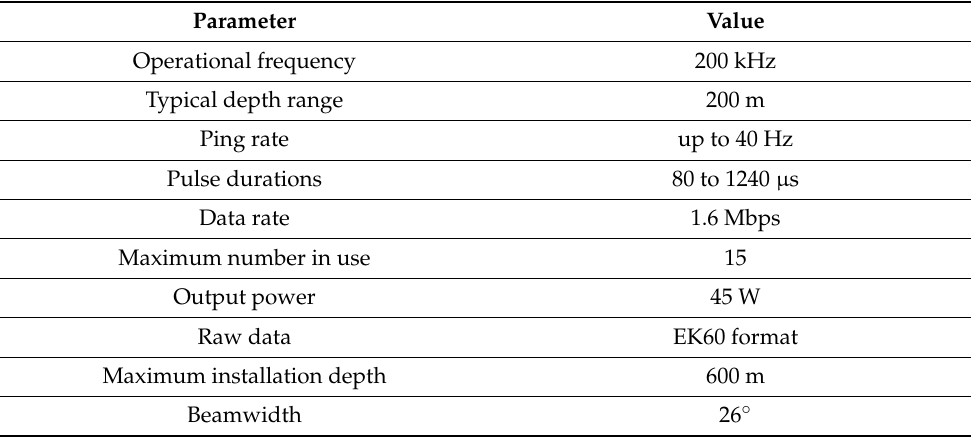
Table 3. Main technical characteristics of the Simrad EK15 Single-Beam Echo Sounder.